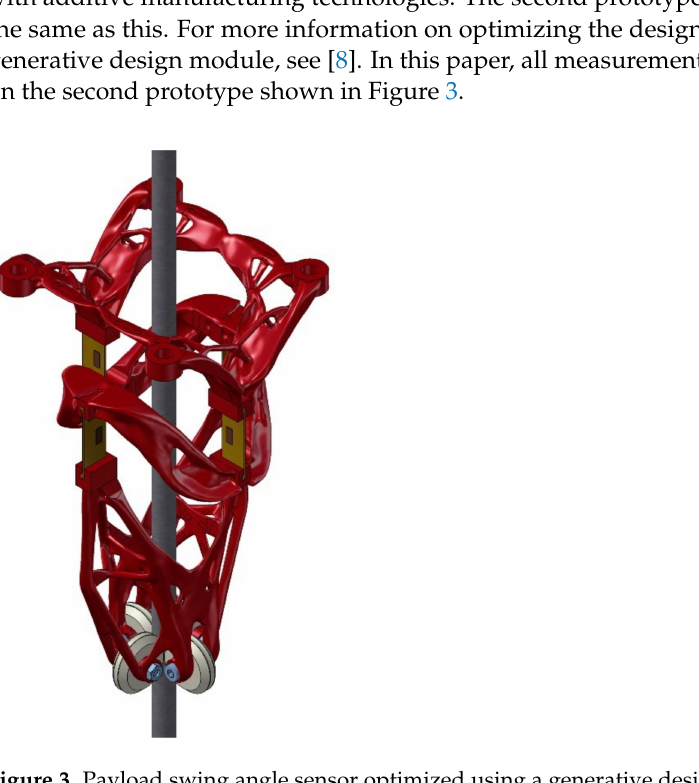
Figure 3. Payload swing angle sensor optimized using a generative design